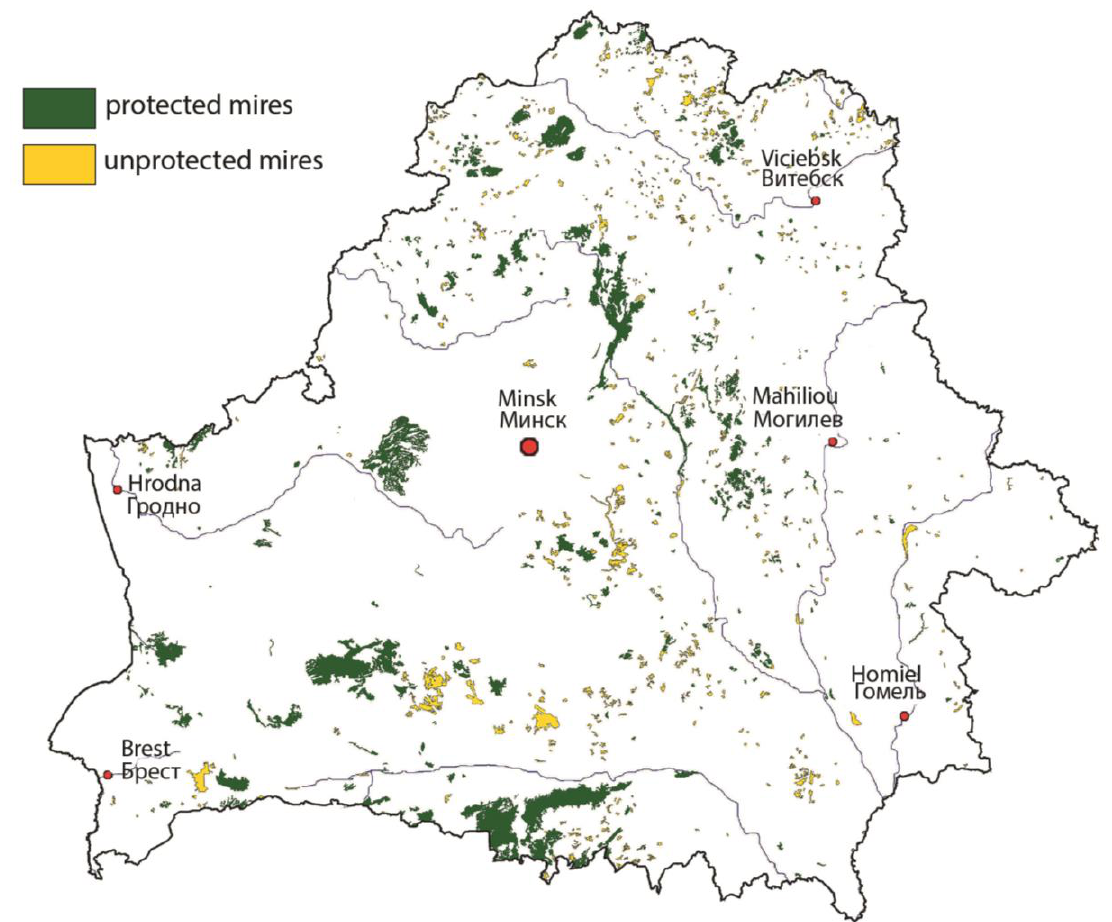
Figure 4. Map of Belarus showing the distributions of protected and unprotected mires. The total area of mires is 863,000 ha, of which 540,000 ha are located within protected